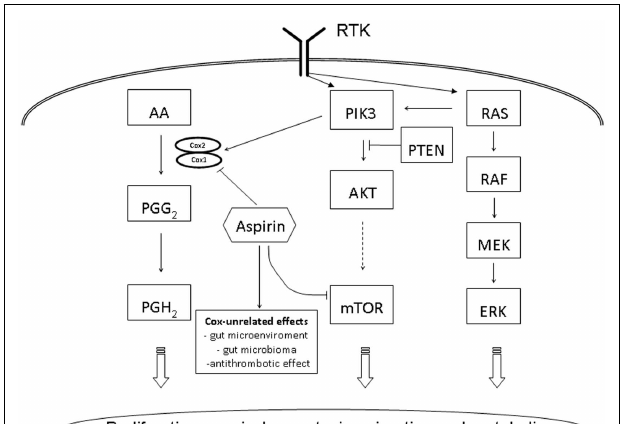
FIGURE 1 | Schematic overview of PIK3CA related cell signaling pathways in colorectal cancer . AA, arachidonic acid; AKT, protein kinase B; ERK, extracellular signal-regulated kinase, MEK, MAP kinase kinase; mTOR, mammalian target of rapamycin; PTEN, phosphatase and tensin homolog deleted on chromosome 10; PGG 2 , prostaglandin G2; PGH 2 , prostaglandin H2; PI3K, phosphatidylinositol-3-kinase; RAF, rapidly accelerated fibrosarcoma; RAS, rat sarcoma; RTK, receptor tyrosine kinase.